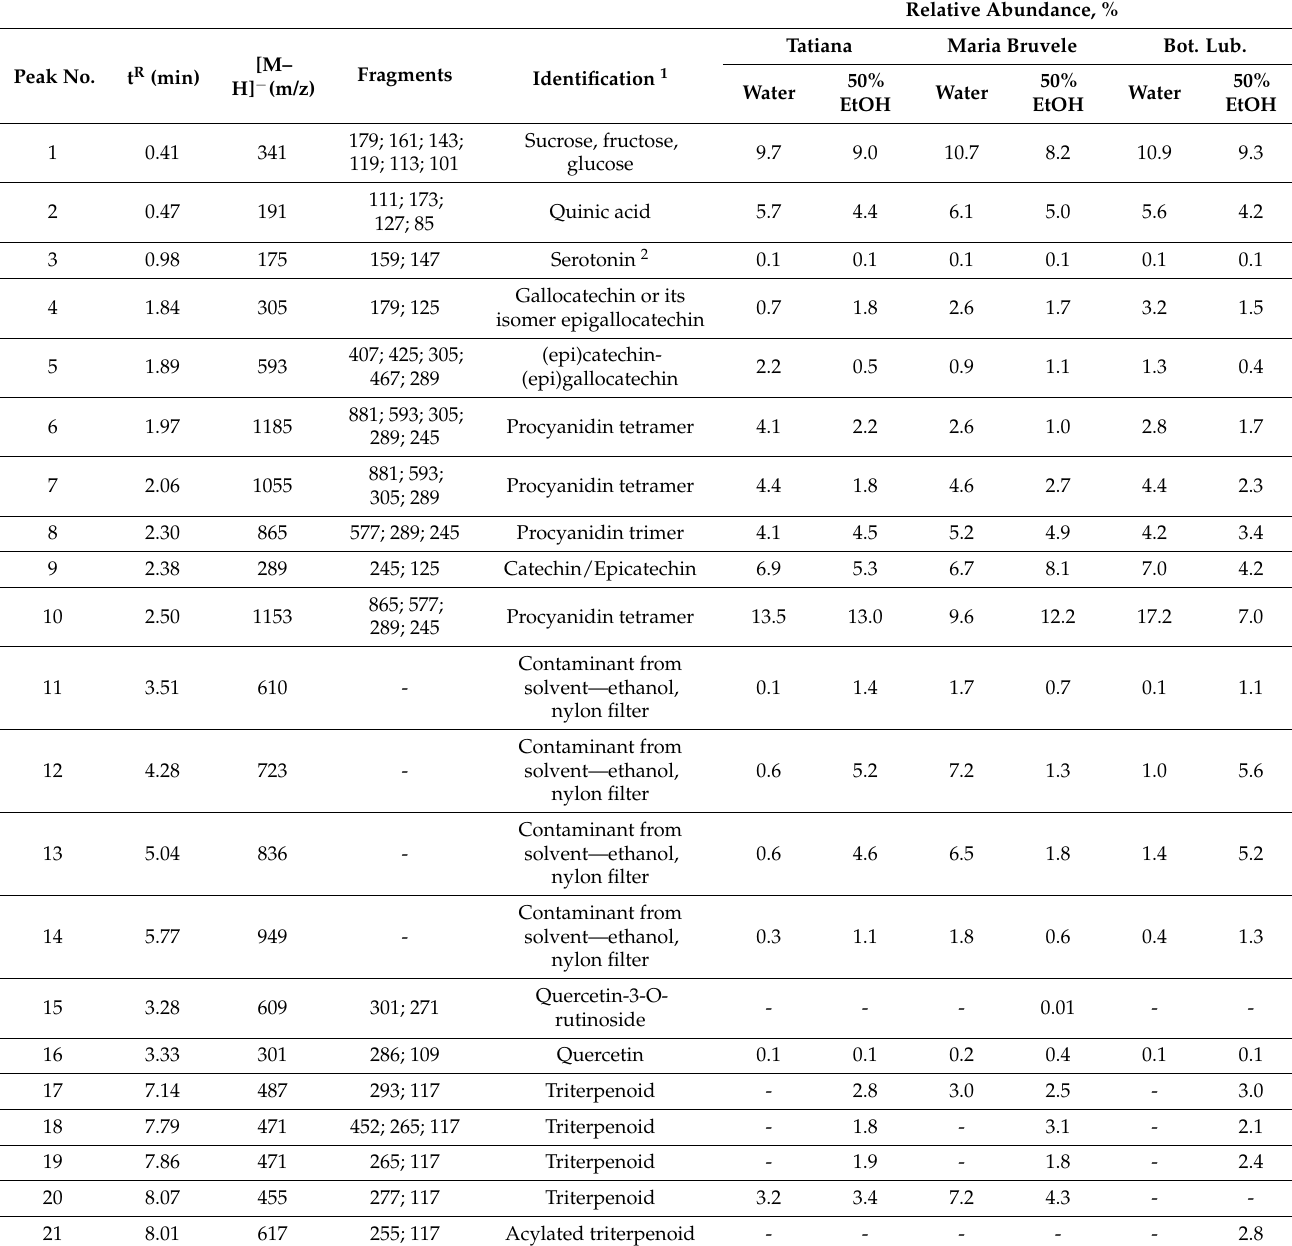
Relative Abundance,